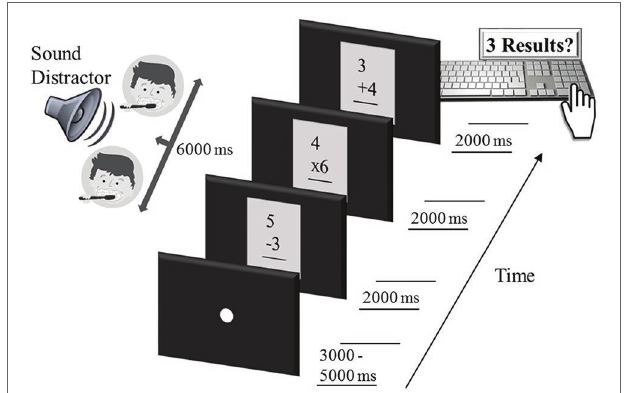
FIGURE 1 | Sequence of an example trial in the intermodal distraction task. Each trial started with a white fixation dot, lasting 3,000–5,000 ms. Subsequently, three single-digit arithmetic problems were shown, each for a duration of 2000 ms, while an auditory distractor (here, brush teeth, falling into the category of low-arousing sounds) was delivered free-field to the participant for the entire period of 6,000 ms. Participants then responded by typing the three calculation results on the number pad of a computer keyboard. After another variable fixation period of 3,000–5,000 ms, the next arithmetic triple, accompanied by a sound distractor, was presented and so